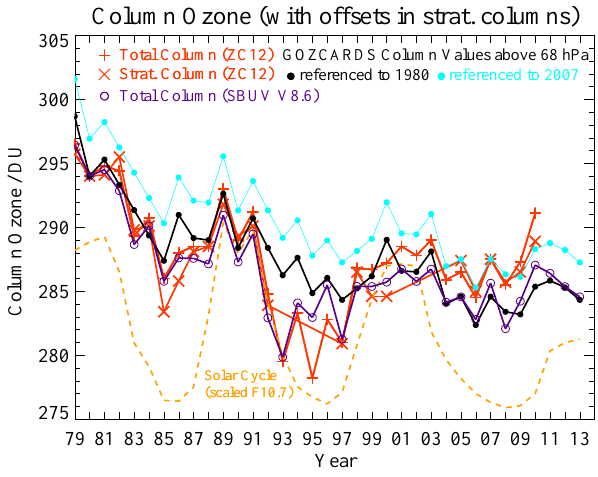
Figure 22. Near-global (60 ◦ S to 60 ◦ N) results for average column ozone (total and stratospheric, from Ziemke and Chandra, 2012) compared to GOZCARDS O 3 columns above 68hPa. Stratospheric columns are offset to better match the total column values, in order to more easily compare relative variations versus time; the black dots and red crosses are referenced to the 1980 total column values, while the cyan curves are referenced to 2007 to better illustrate the fits in the later years. Also shown (as purple open circles) are yearly averaged total column data (60 ◦ S to 60 ◦ N) from the SBUV Merged Ozone (V8.6) Data Set (see text); these values were adjusted upward slightly (by 0.8DU) to match the ZC12 total column values in